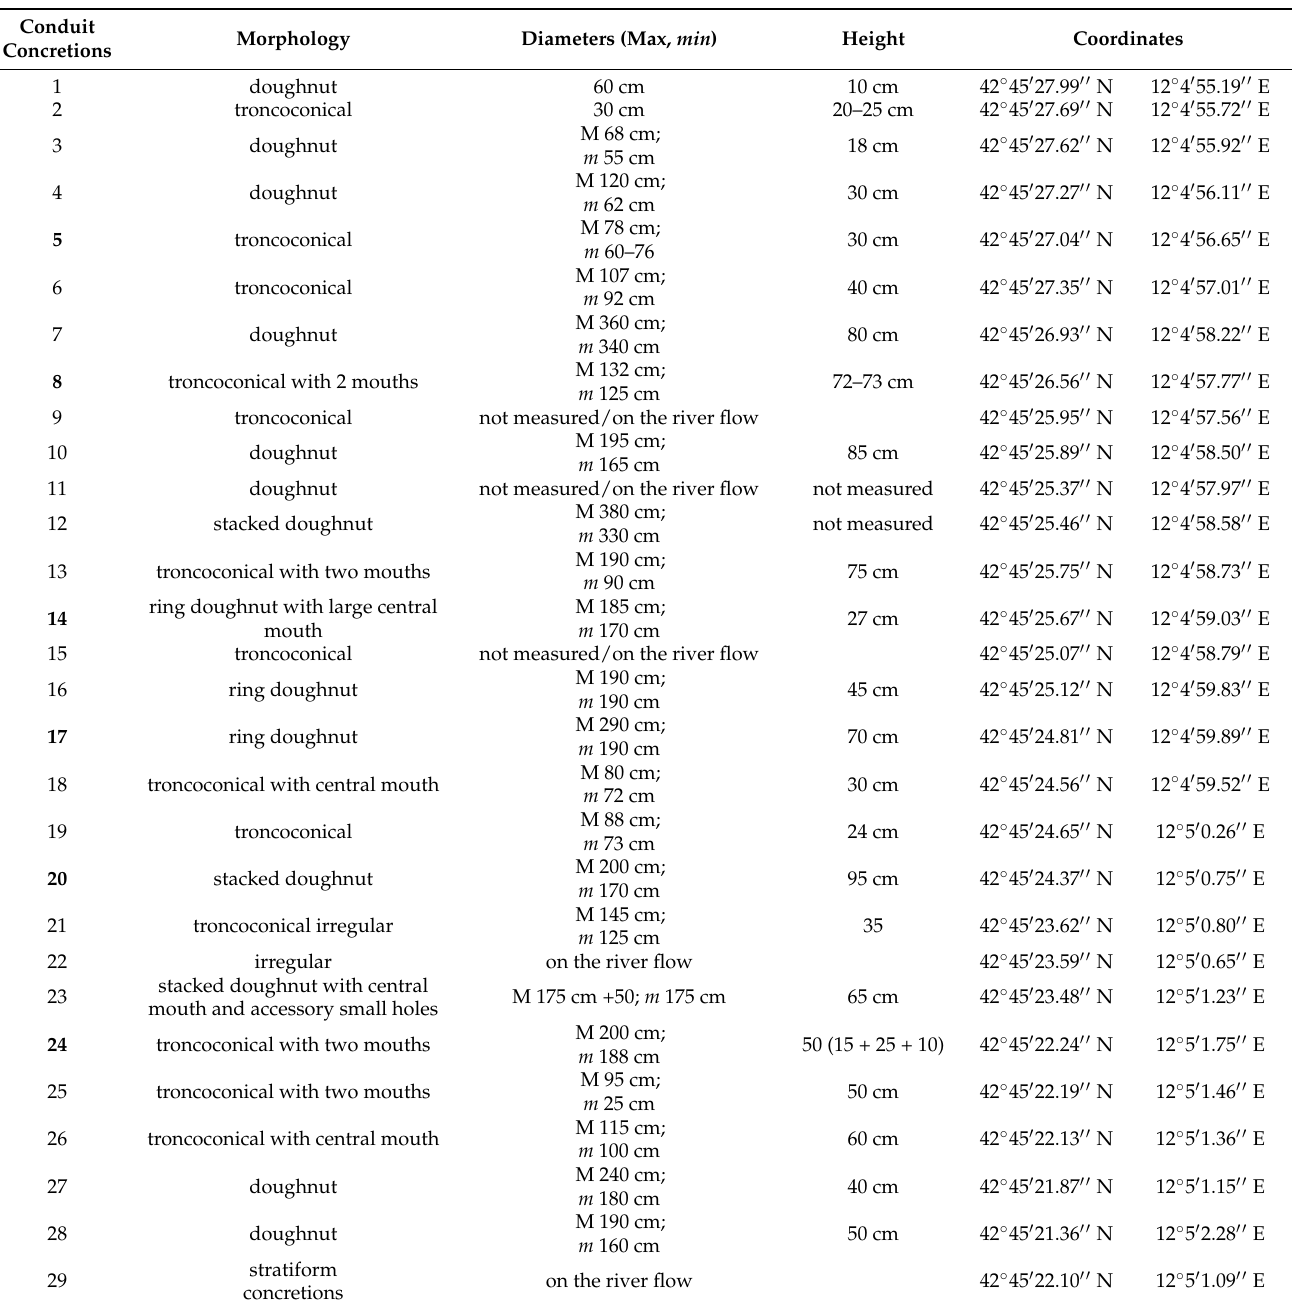
Figure 4. Biostratigraphic and micropaleontological data were obtained for two samples (PAG 1 and PAG 2) of hosting clay sediments (collected just above structures #4 and #5) and 1 clay sample (PAG 3) collected outside of structure #14 (Figure 4i). Table 1. Details of the morphology, sizes (diameters and heights), and GPS coordinates of the conduit concretions identified in the 2016 and 2017 surveys. Bold numbers indicate the analysed